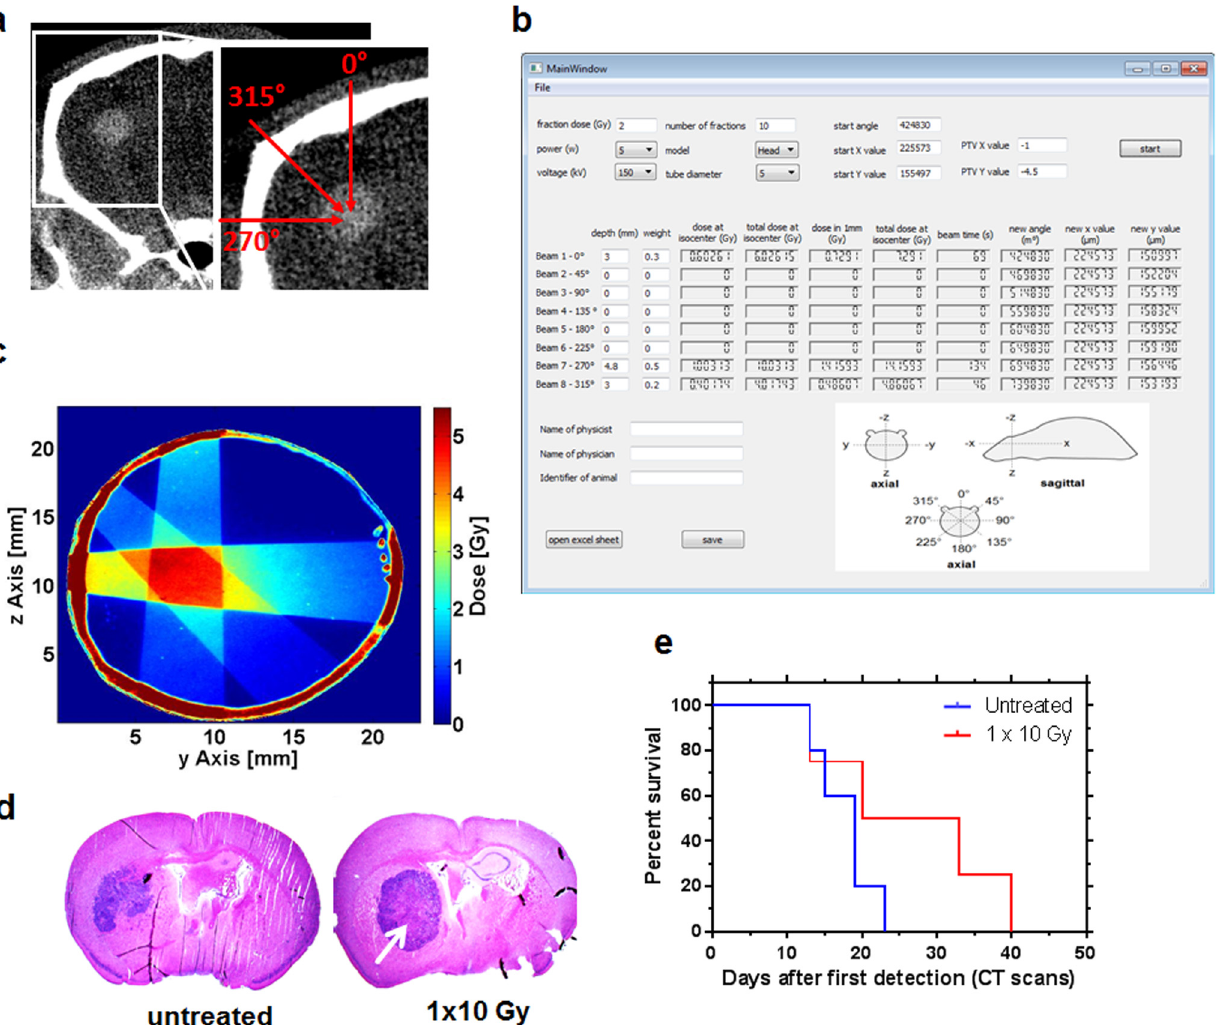
Fig 2. Proof of principle using an orthotopic implant model. (a) CT scans used to measure tumor depths and example for a plan using 3 irradiation angles (0°, 270° and 315°). (b) Graphical user interface of the planning application with a standard treatment scheme. (c) Dose distribution of a three-beam plan (details shown in b) in the head phantom measured with a Gafchromic film. (d) Treated tumors show extensive necrotic areas (white arrow) after irradiation, which were not present in untreated tumors. (e) Survival plots of irradiated and untreated